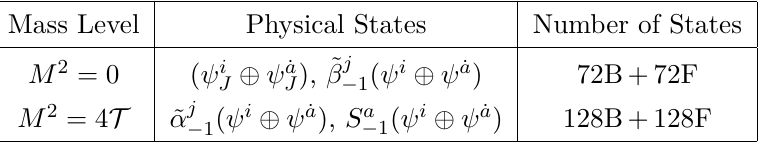
Table 1 . N = 1 SYM + SUGRA, and the 1st. massive level of the open superstring from the quantization of heterotic chiral